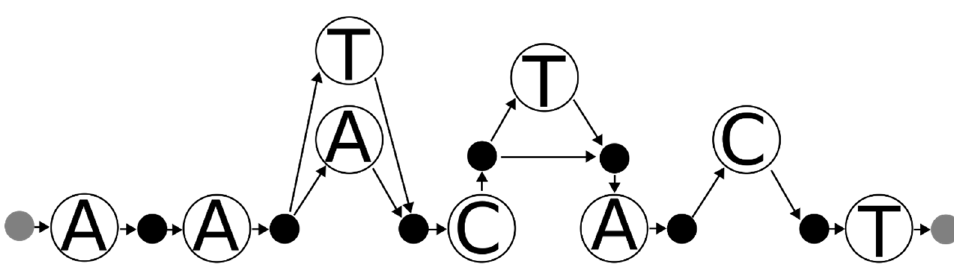
Figure 7. The graph from Figure 6 with an insertion added (4.1T). Note that this insertion adds an additional epsilon node.